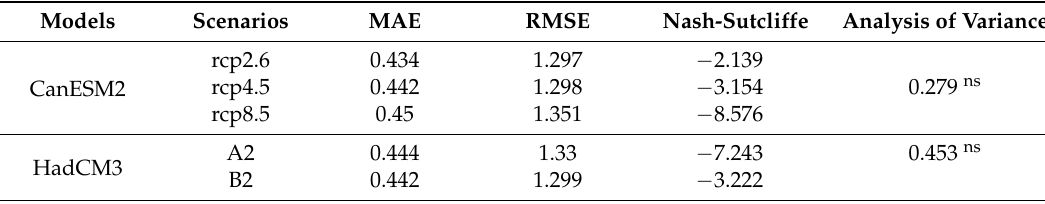
Results of the efficiency evaluation of the used scenarios for the annual precipitation predictions.